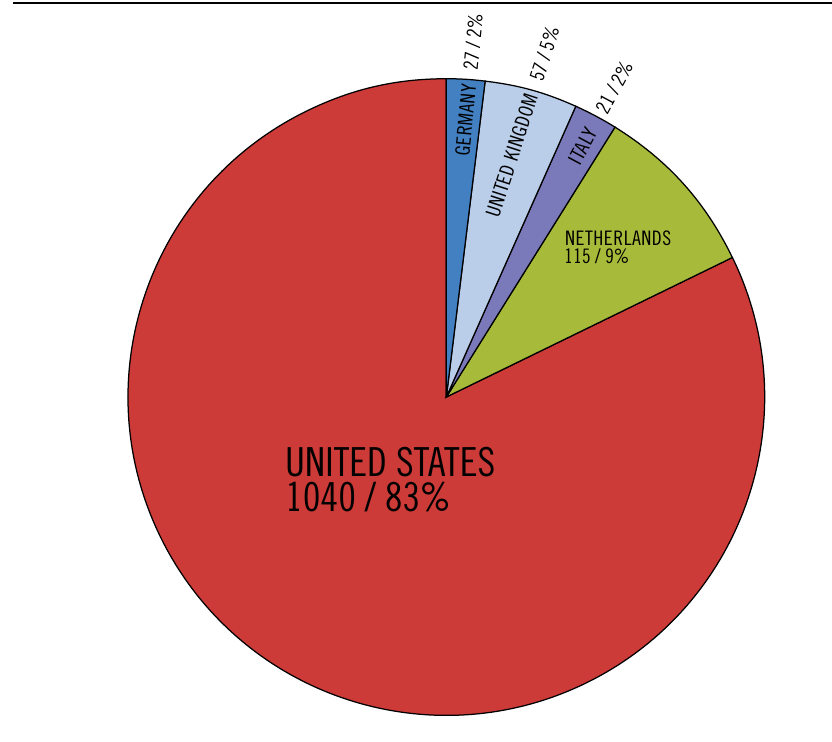
Figure 1 – Distribution of Subsidiary Ownership in 1962 Figure 2 – Distribution of Subsidiary Ownership in